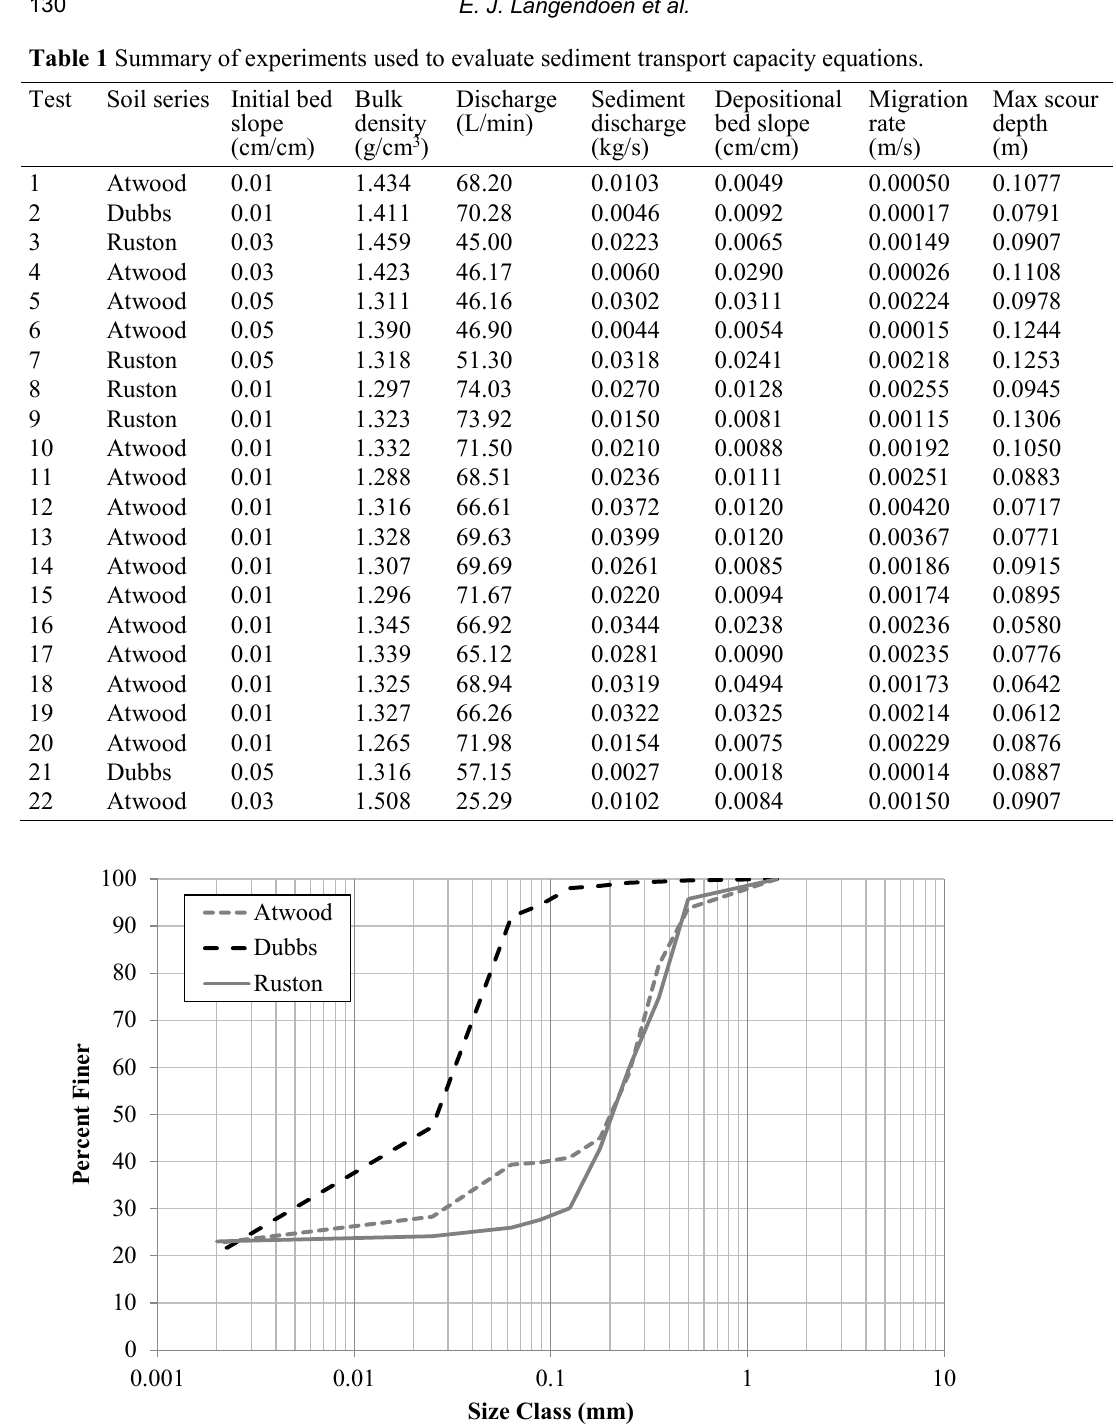
Fig. 1 Grain size distributions of soils